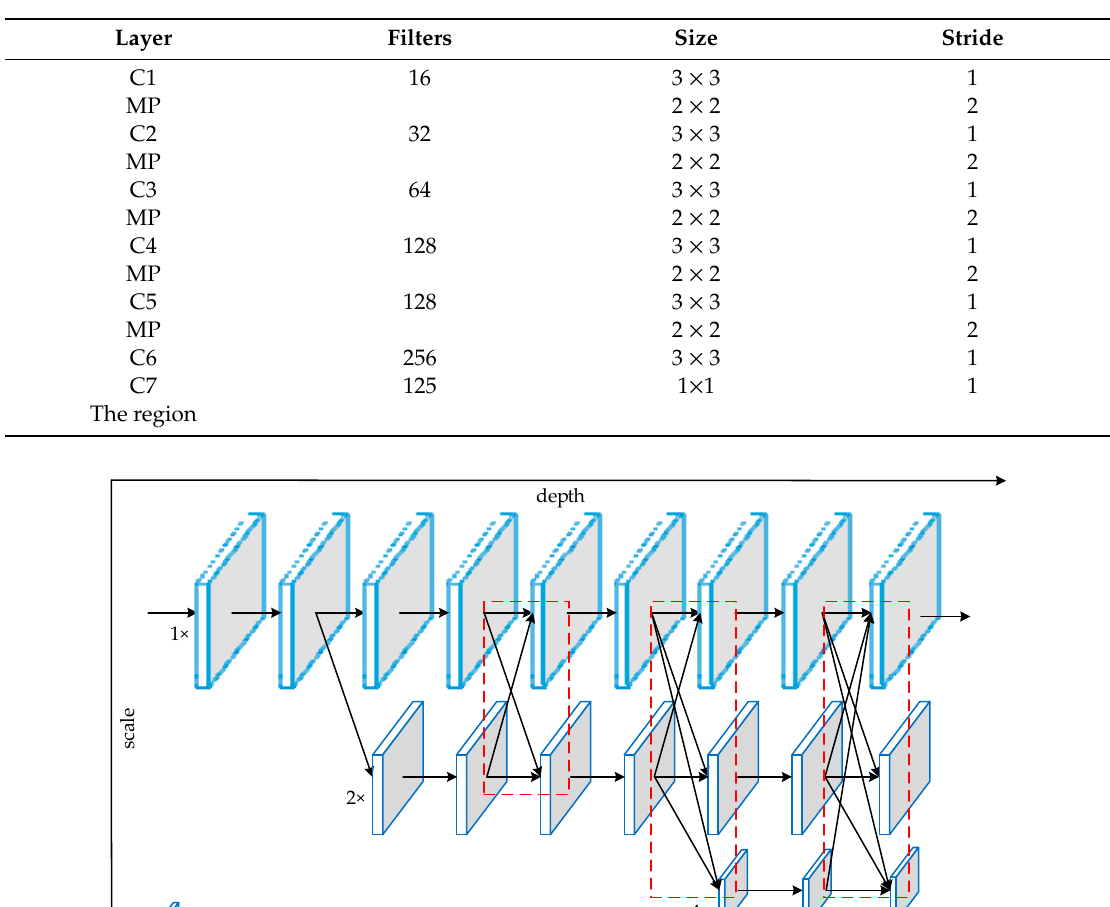
Table 1. YOLO-LITE architecture.